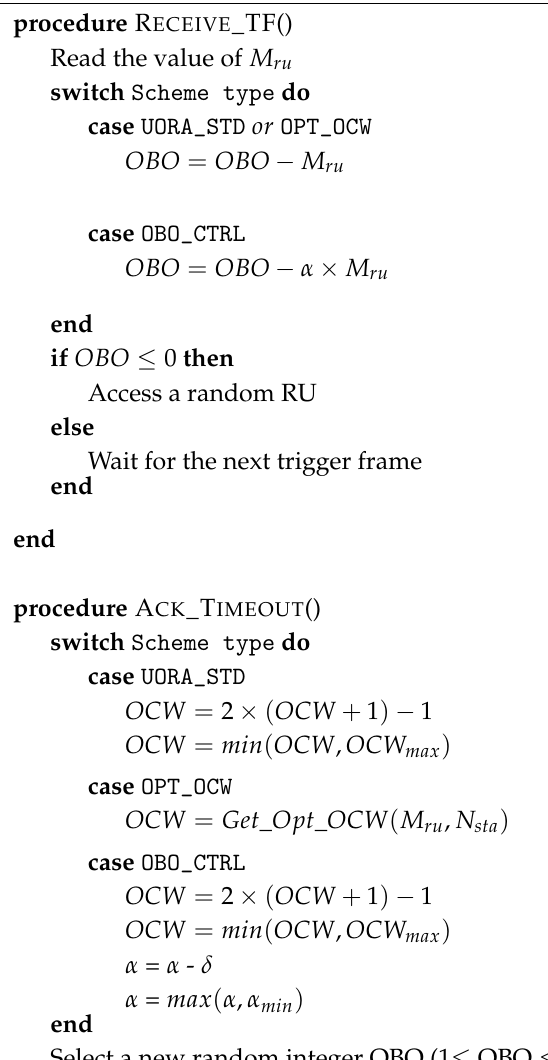
Algorithm 1 : procedures for the three UORA